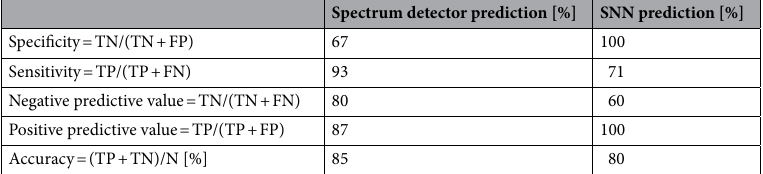
Table 3. The occurrence of HFO is associated with epilepsy state. Comparison of epilepsy state prediction (active epilepsy: seizures/month > 0) between the Spectrum detector and the SNN. TP True Positive; TN True Negative; FP False Positive; FN False Negative; N = TP + TN + FP + FN = number of